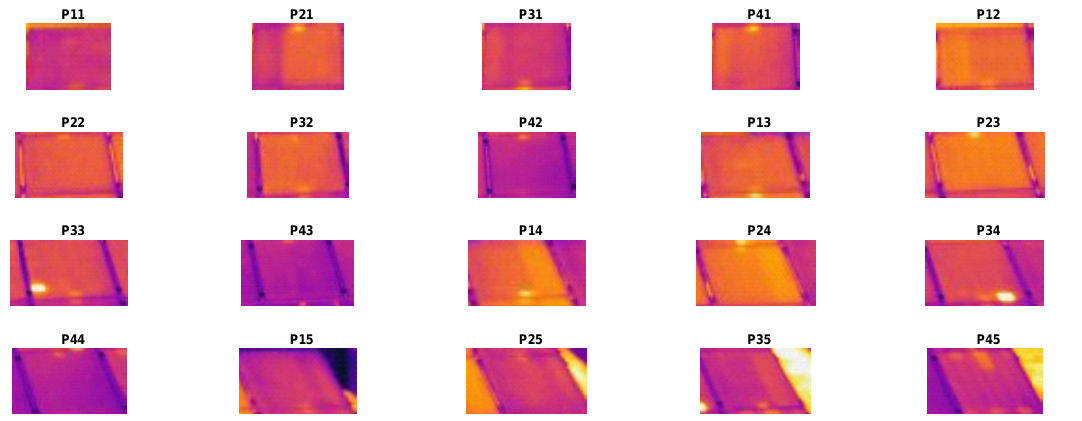
Figure 15. Window creation for each PV module.